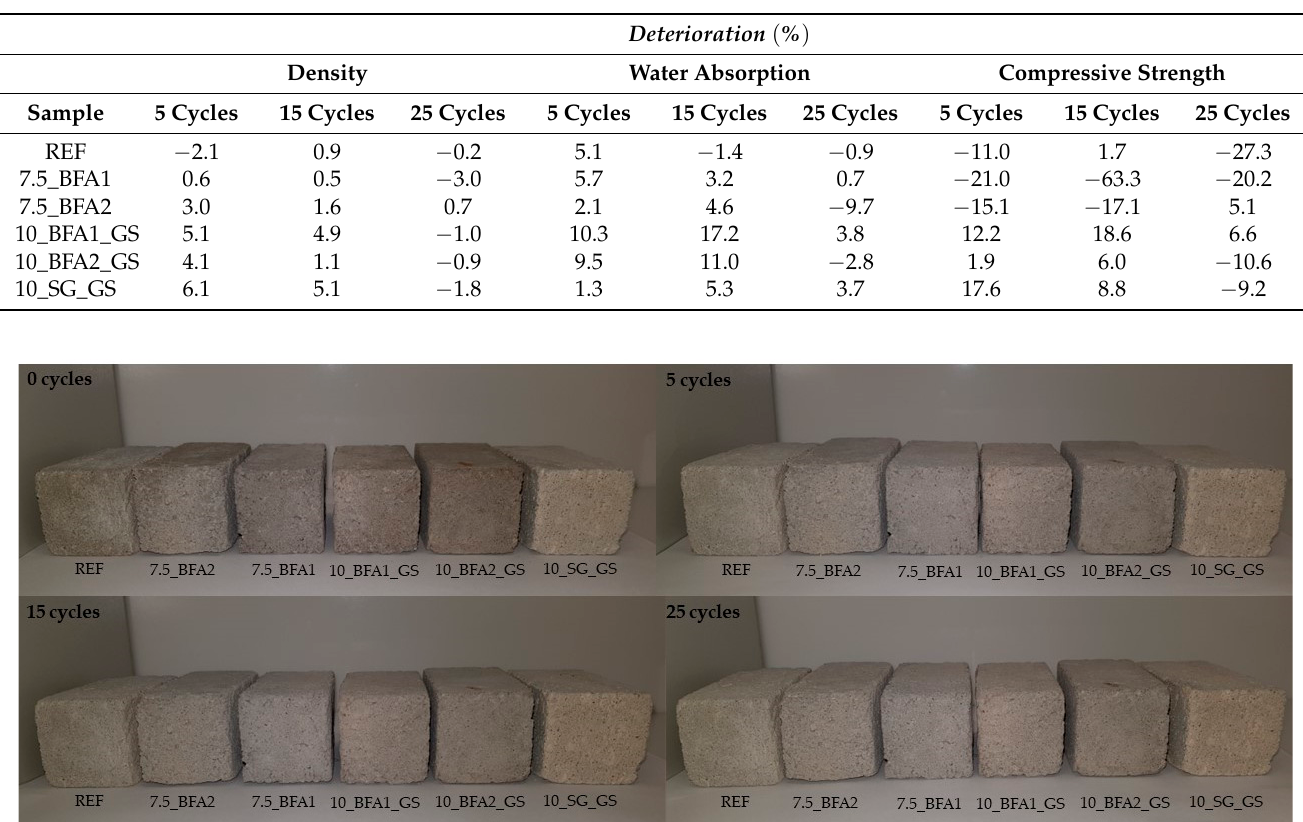
scenario, the paper-pulp producer is only 6 km away from the mortar producer.